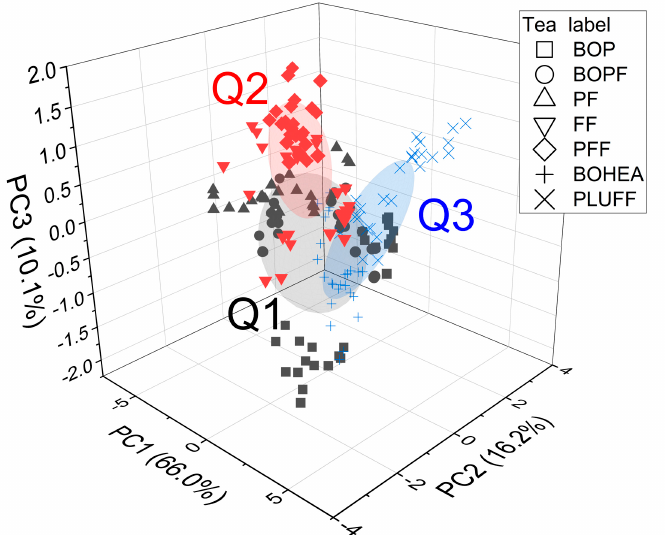
Figure 4. PCA 3D plots with confident level 50% regarding the unsupervised classification of tea samples from different brands (BOHEA, BOP, BOPF, FF, PF and PLUFF, as listed in Table 1) according to their quality grades (Q1, Q2 and Q3) based on the E-nose profiles after signal preprocessing data treatment using F 2 procedure. PC1, PC2 and PC3 are the 1 st , 2 nd and 3 rd principal component functions.